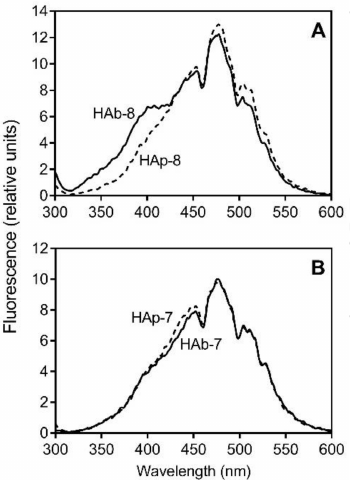
Figure 3. Synchronous fluorescence spectra of selected HA fractions. Solutions of HAb-8 and HAp-8 ( Panel A ) and solutions of HAb-7 and HAp-7 ( Panel B ) (10 µ g/mL in 25 mM NaHCO 3 ) were analyzed with a scanning fluorometer, and the synchronous spectra ( ∆ λ = 20 nm) are shown.